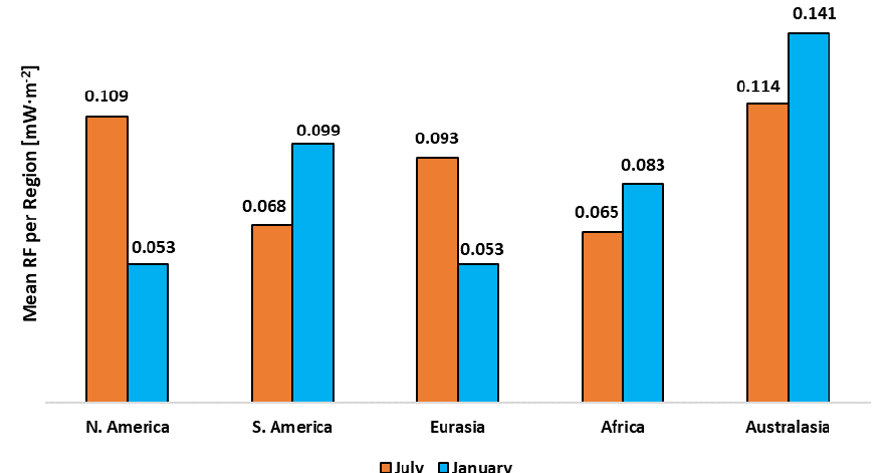
Figure 14. Mean RF in milliwatts per square meter (mWm − 2 ) by region of emission during January and July of 2014 for a 5 × 10 5 kg (NO) emission. Table 2. Source–receptor matrix. Receptor regions defined according to Fig. 2. NA: North America, NTA: Northern Trans-Atlantic, SA: South America, EU: Europe, AME: Africa & Middle East, AS: Asia, AUS: Australasia, NTP: Northern Trans-Pacific, STP: Southern Trans- Pacific. Results are for a 5 × 10 5 kg (NO) emission. The figures in bold represent the maximum RF values attained at a receptor for a given source. Receptor Mean RF [mWm − 2 ] NA NTA SA EU AME